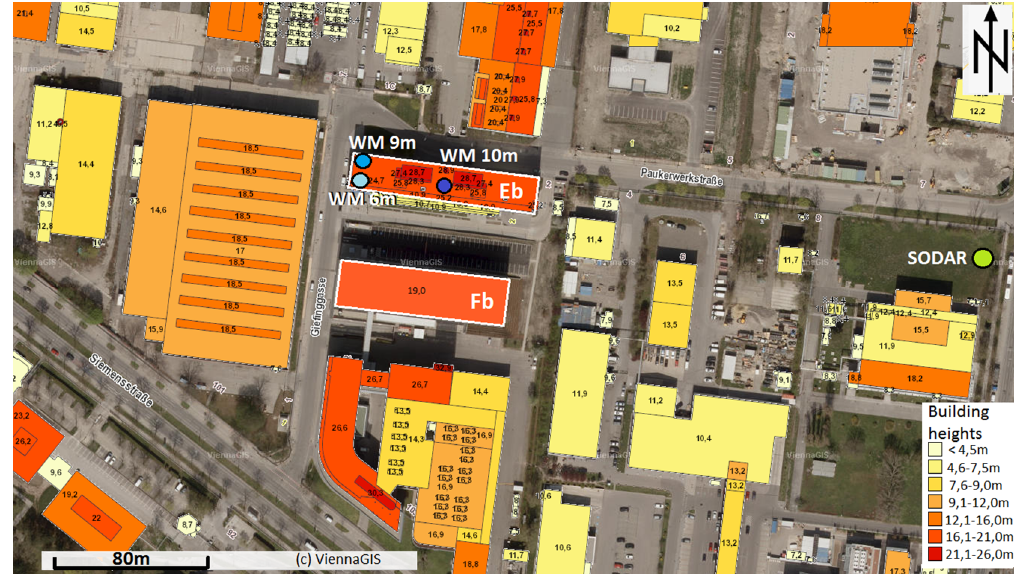
Figure 2. Map of the site of the buildings ENERGYbase (Eb) and FUTUREbase (Fb) with position of masts with wind measurements at 6 m (WM 6 m, light blue dot), at 9 m (WM 9m, mid-blue dot) and at 6 m and 10 m (WM 10m, dark blue dot) height at roof top and of position of the SODAR site (green dot).